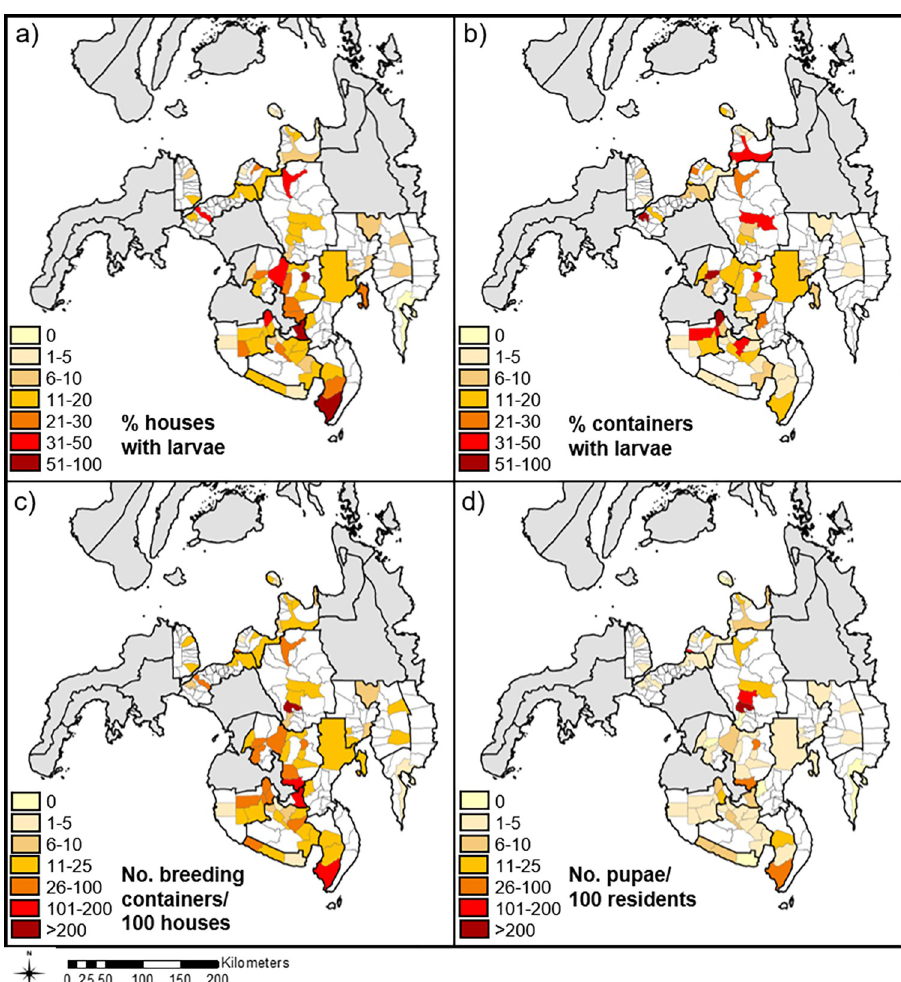
Fig 5. Spatial pattern of vector surveillance indices across the southern Philippines, 2013–2018. Mean monthly values for four vector surveillance indices are shown across 65 areas of the southern Philippines for the 6-year period. a) House Index, b) Container Index, c) Breteau Index and d) Pupal Productivity Index. The relative breeding intensity are shown by graduated colours. Areas not surveyed are indicated in white. Map data derived from the Humanitarian Data Exchange